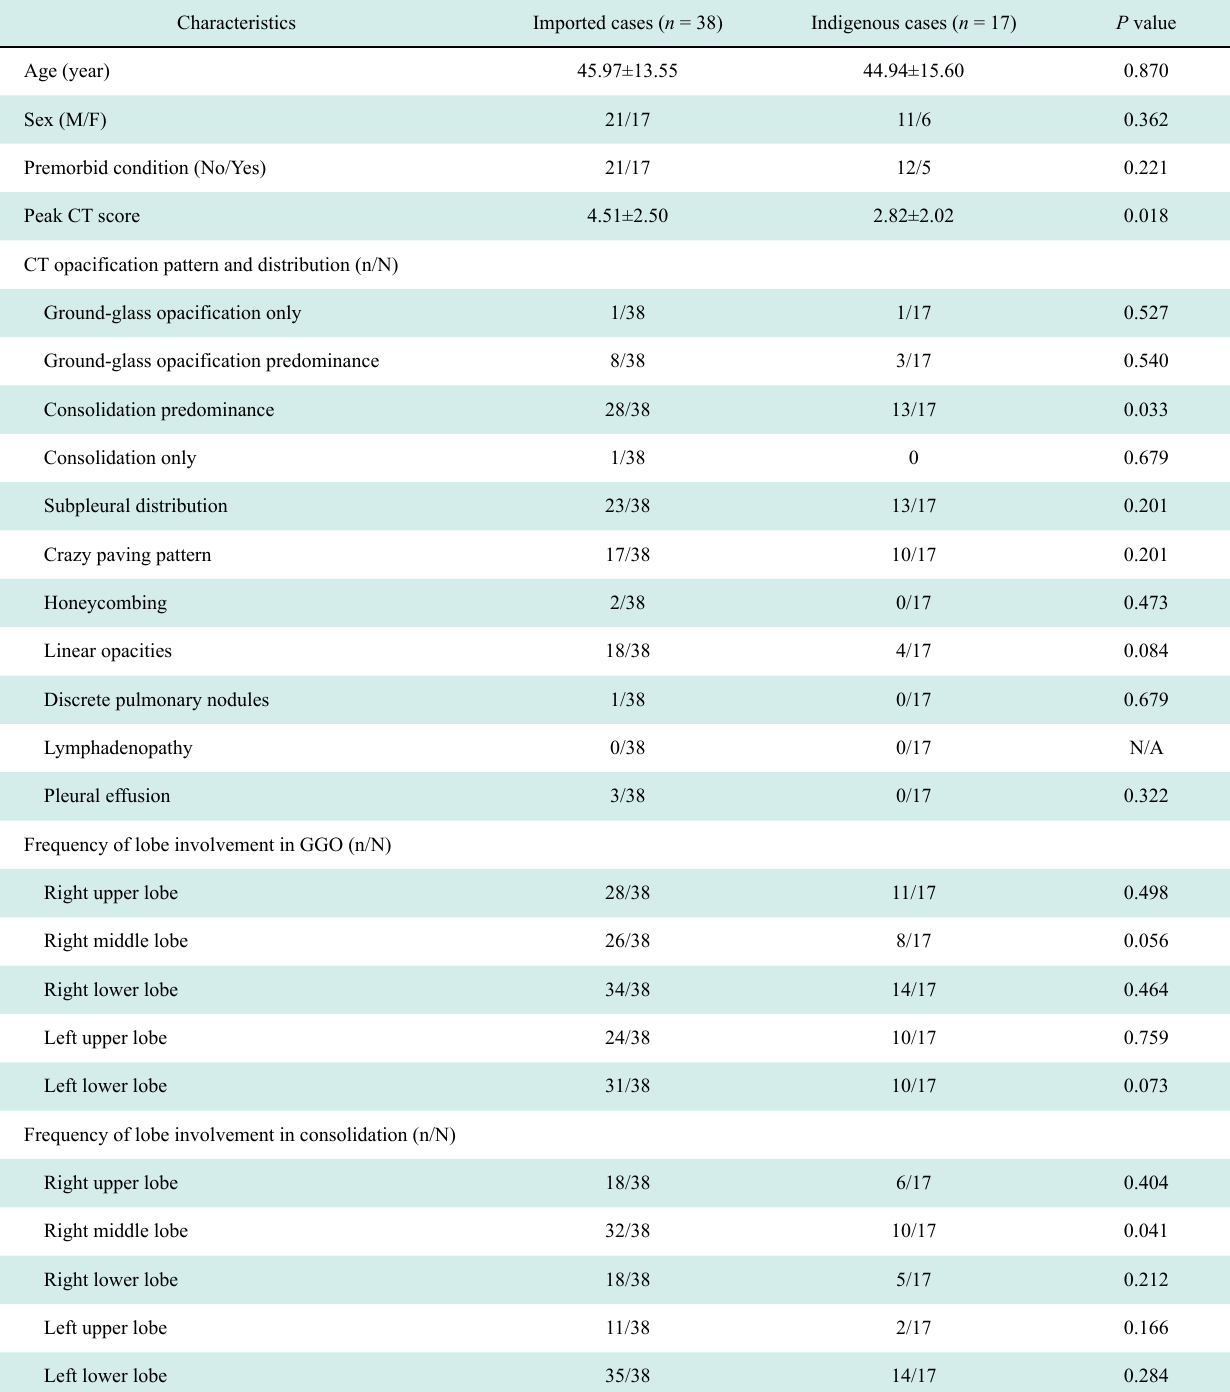
Table 3 Comparison of radiological characteristics of 55 COVID-19 pneumonia cases between imported and indigenous group